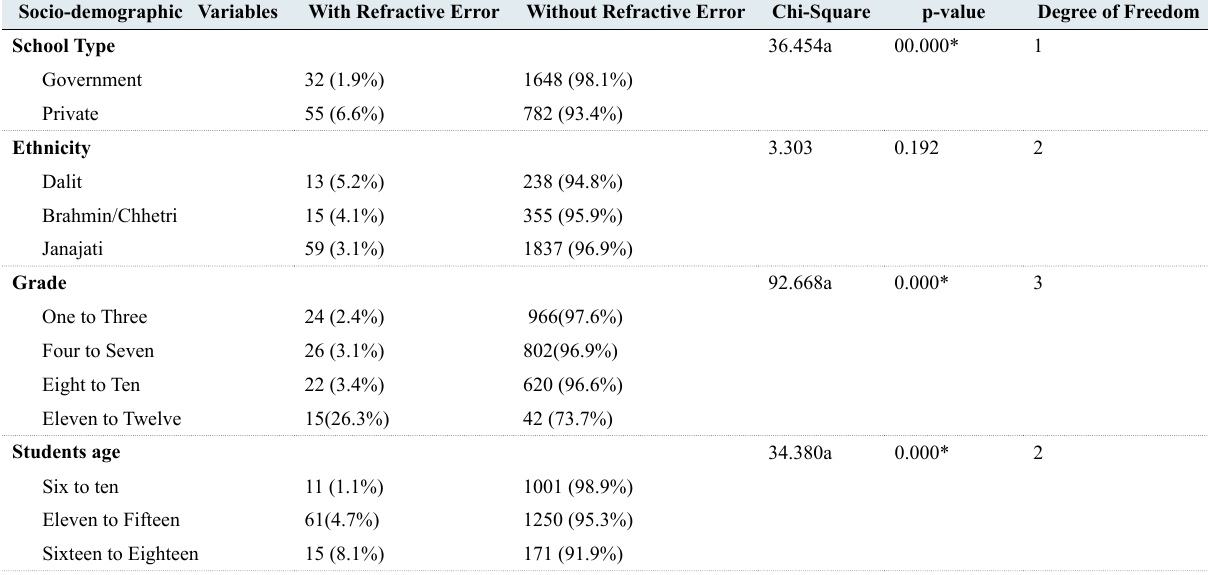
Table 1. Cross-tabulation of Students with refractive error and without refractive error with different socio-demographic